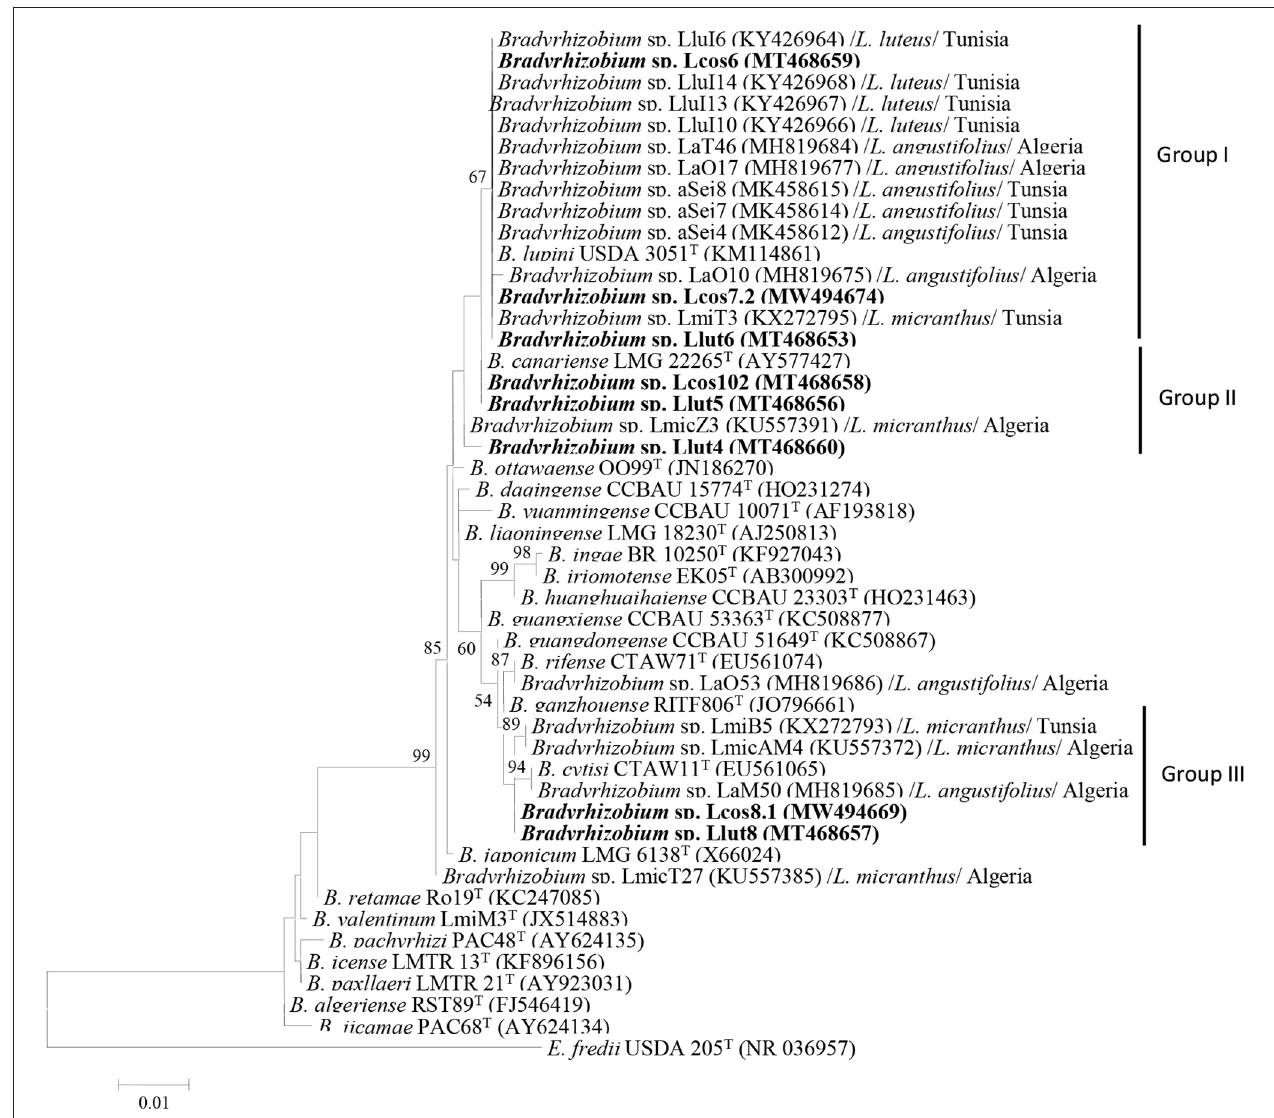
FIGURE 1 | Maximum likelihood phylogenetic tree based on 16S rRNA sequences of rhizobial strains from nodules L. cosentinii and L. luteus grown in the Maamora forest and phylogenetically related species within the genus Bradyrhizobium . The analysis was based on 1,400 nucleotides. Isolates from this study are denoted in bold. Bootstrap values are indicated as percentages derived from 1,000 replications. Values lower than 50% are not shown. Bar, 1 nucleotide substitution per 100 nucleotides. The tree is rooted with Ensifer fredii USDA 205 T .